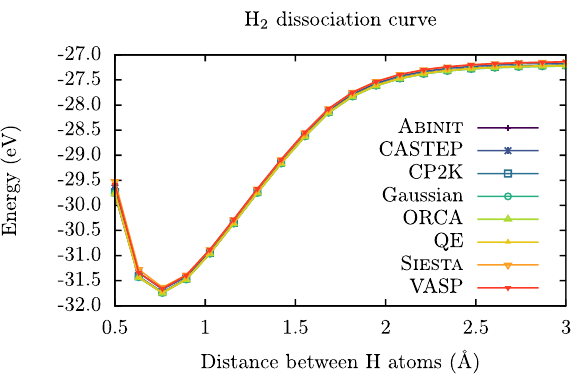
Fig. 9 Dissociation curve of the H 2 molecule. Results obtained with a code-agnostic work fl ow. For all codes and all volumes, the magnetization is initialized to − 1 μ B for one atom and to + 1 μ B for the other atom. The label QE stands for Quantum ESPRESSO. The VASP curve has been shifted by − 24.89 eV. Results are missing for BigDFT, FLEUR, and NWChem (see Supplementary Table 2 for more